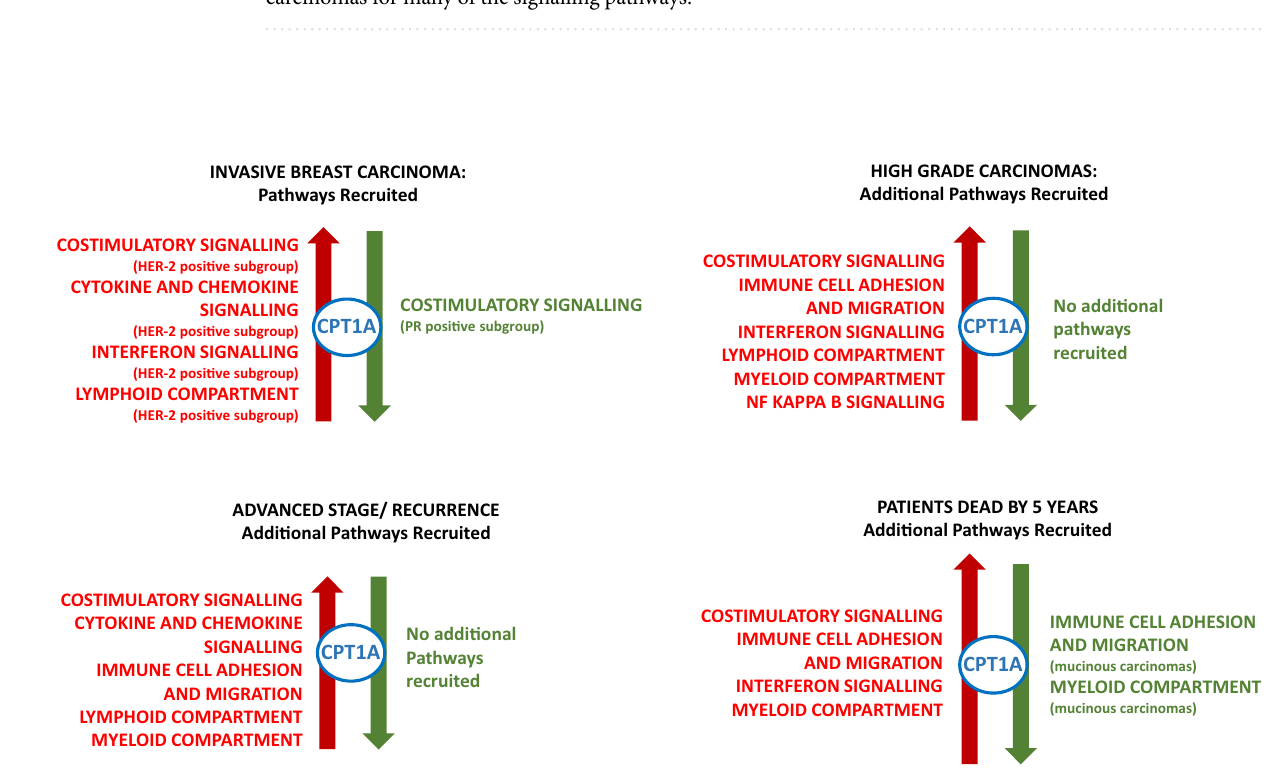
Figure 3. CPT1A clustering with epigenetic pathways. Visual depiction of the clustering of CPT-1A with signalling pathways and whether the clustering occurs in the context of overexpression (red colour, left) or underexpression (green colour, right). The remaining two images on the right show that phosphorylation is the only additional pathway to be recruited in female patients with advanced stage, recurrence and a worse prognosis, as indicated by death by 5 years. All male breast carcinomas showed clustering with phosphorylation in the primary tumours. Over and under-expressing subgroups were identified among the primary breast carcinomas for many of the signalling pathways.